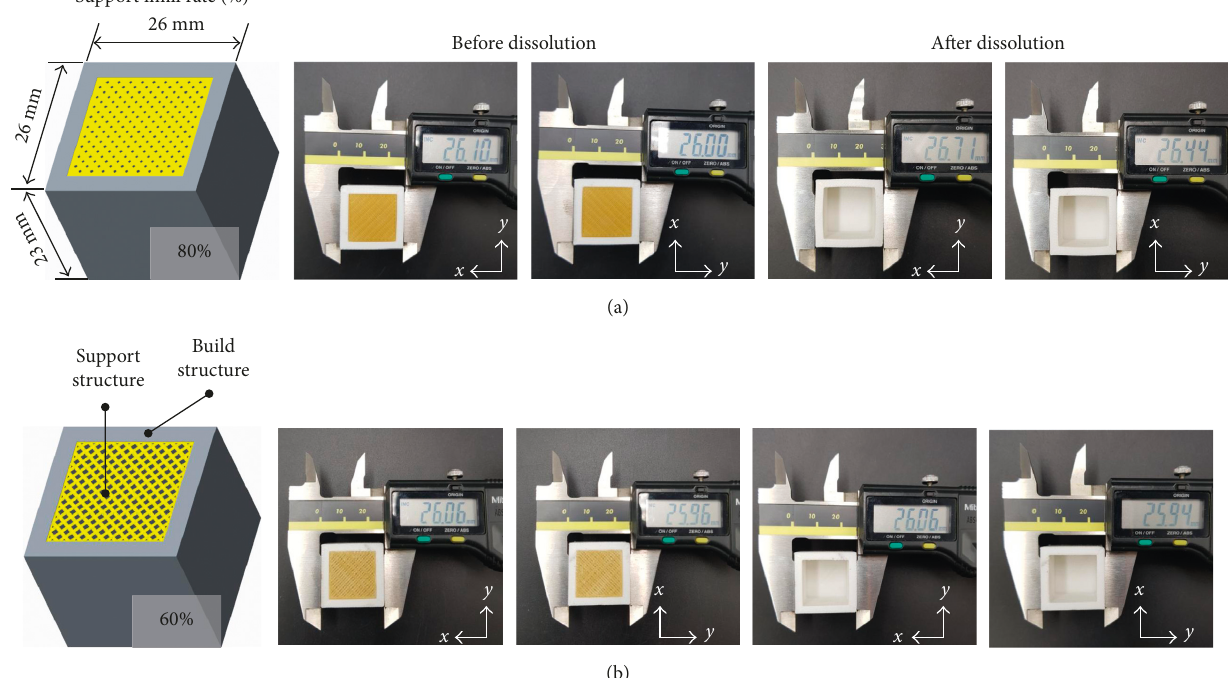
Figure 9: Change in (a) tensile strength and (b) weight of direction-varied specimens after H specimens were tested in each experiment, and the tensile strength is shown as the mean ± standard deviation.